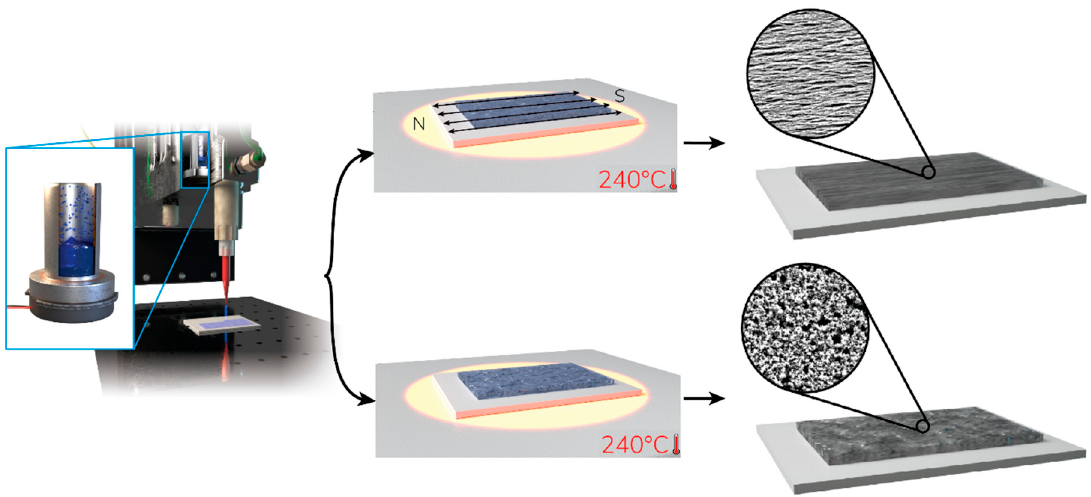
Figure 1. Schematic illustration of printing a Ni precursor ink and sintering it in presence of homogeneous magnetic field to reduce the complex to aligned nanowires.